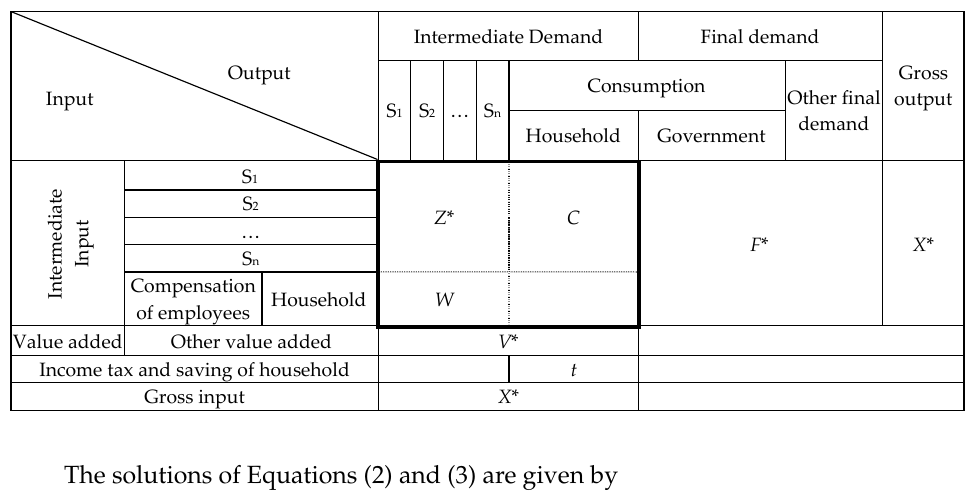
framework of the semi-closed IO model. Table 1. Framework of the semi-closed IO model. Table 1. Framework of the semi-closed IO